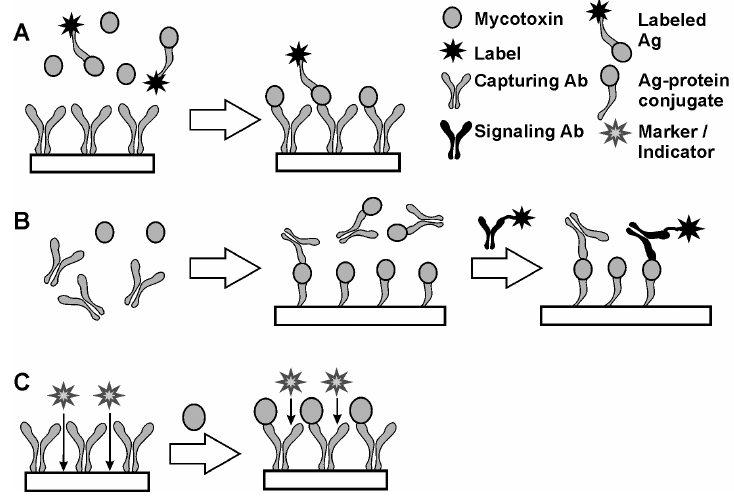
Figure 3. Direct ( A ), indirect ( B ) immunoassay ( A ) and label-free protocol ( C ) of hapten